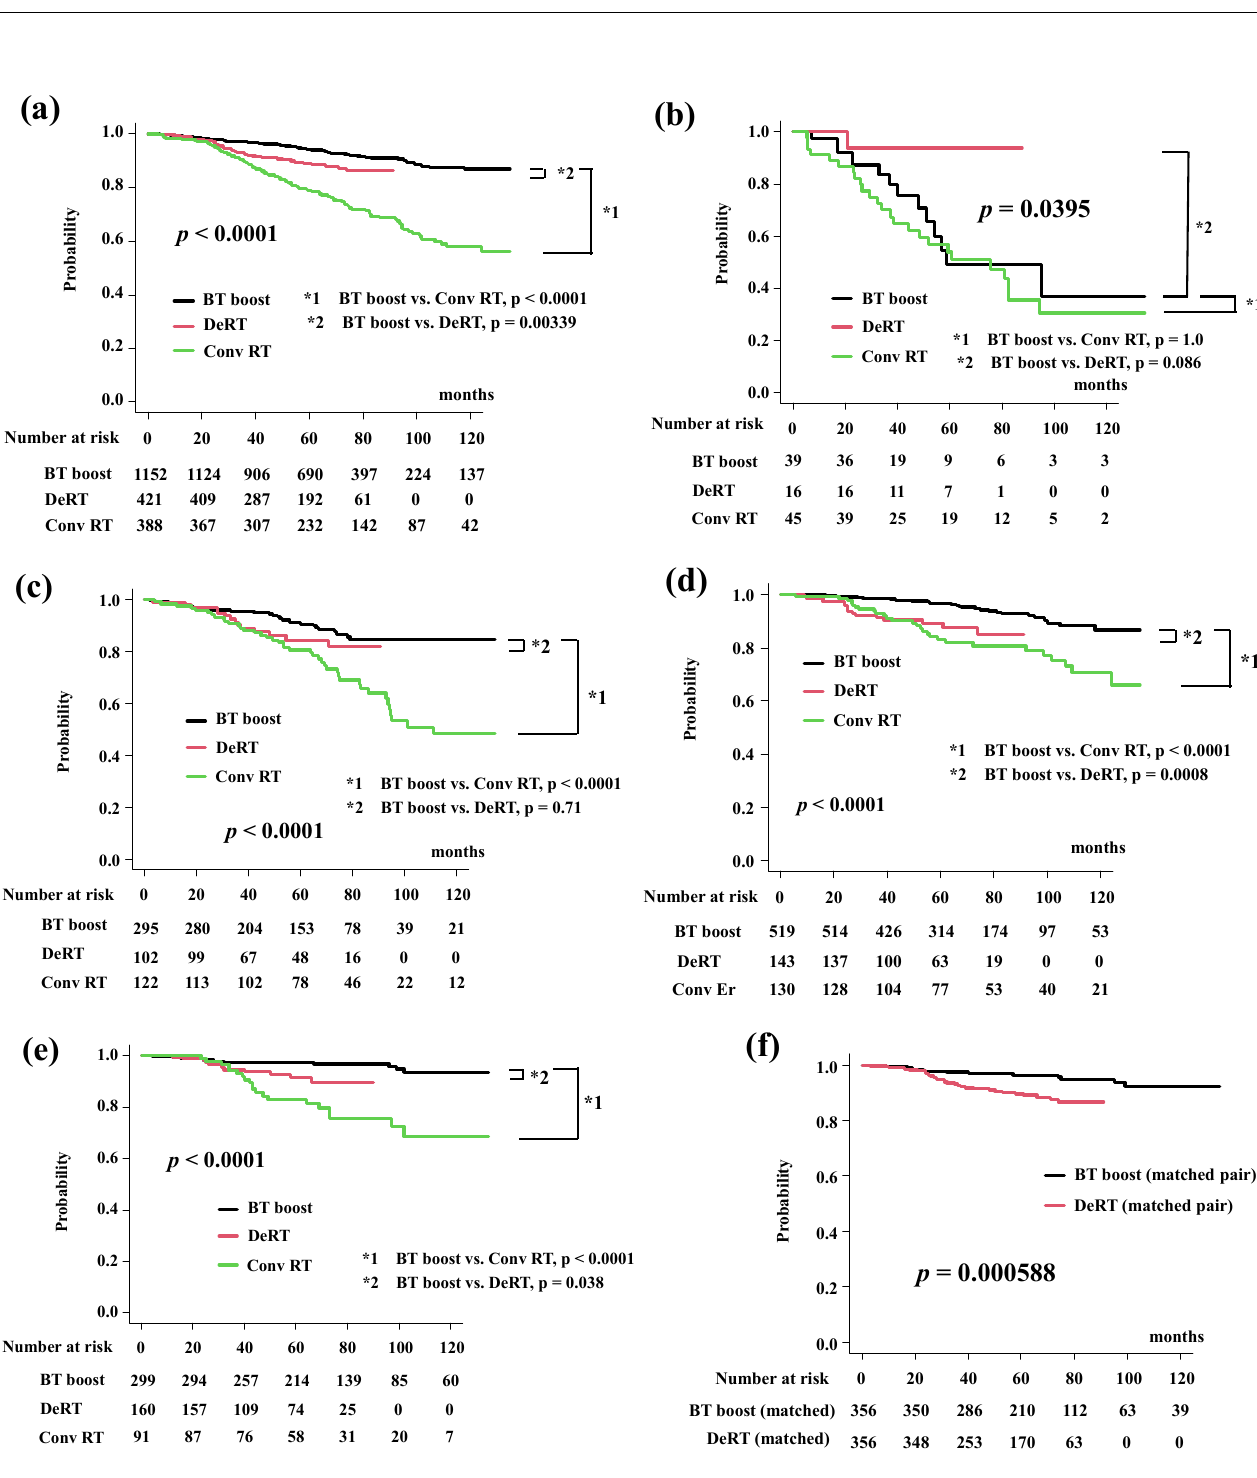
Figure 2. Biochemical control rates among three groups (BT-boost vs. Conv RT vs. DeRT). ( a ) Comparison of bDFS among three groups. ( b ) Comparison of bDFS among three groups in VHR-2 group. ( c ) Comparison of bDFS among three groups in VHR-1 group. ( d ) Comparison of bDFS among three groups in VHR-0 group. ( e ) Comparison of bDFS among three groups in intermediate-risk group. ( f ) Comparison of bDFS between dose escalated radiotherapy (DeRT) and BT-boost using matched pair analysis. bDFS = biochemical disease-free survival rate.